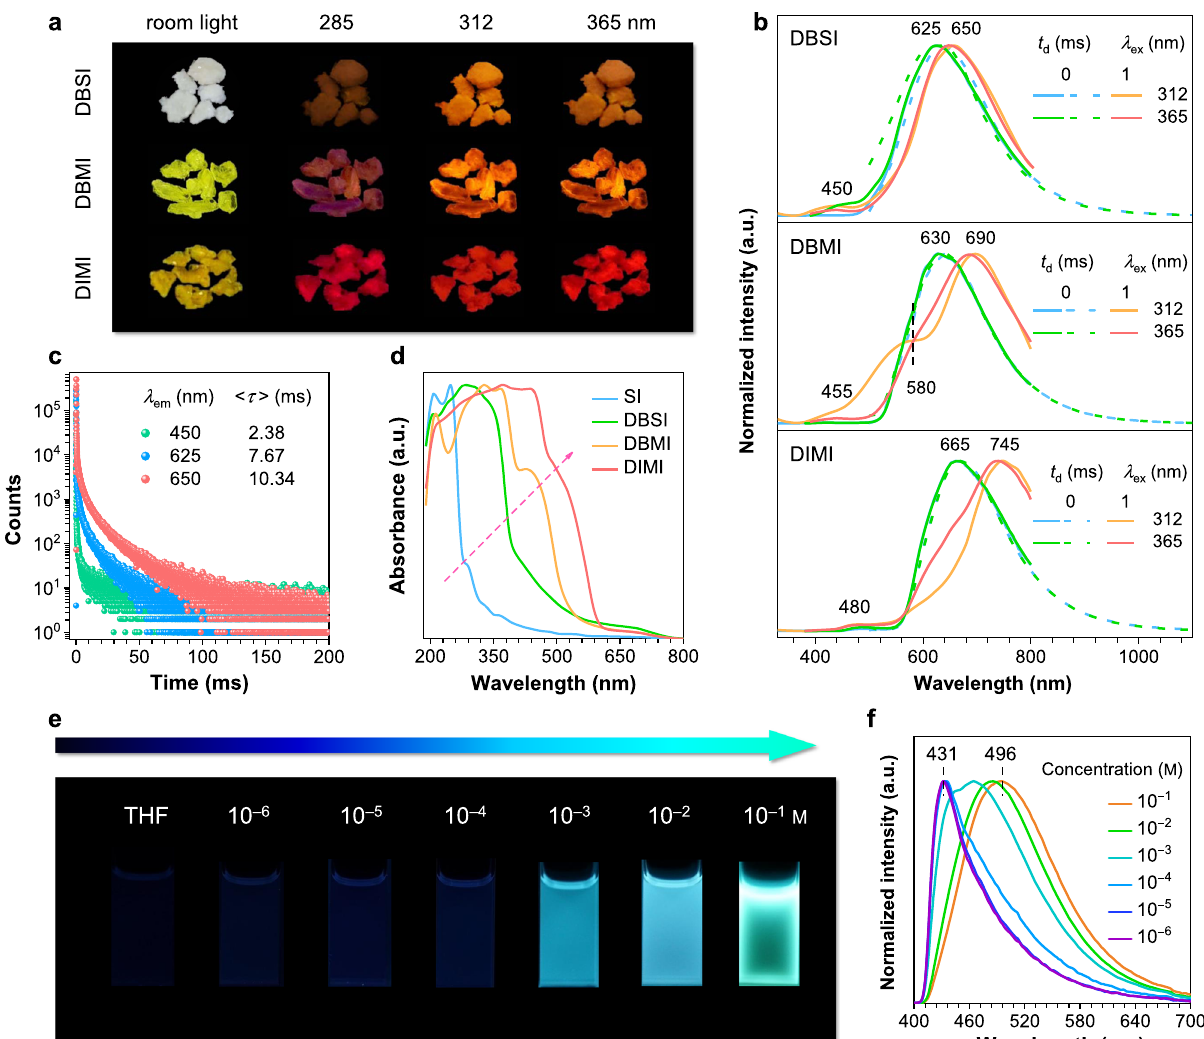
Fig. 2 Photophysical properties of DBSI, DBMI, and DIMI. a Photographs taken under room light or varying UV lights and b prompt ( t d = 0 ms) and delayed ( t d = 1 ms) emission spectra with varying λ ex s of DBSI, DBMI, and DIMI single crystals. c Lifetime pro fi les of DBSI single crystals monitored at different λ em s ( λ ex = 312 nm). d Absorption of different single crystals. e Photographs and f normalized emission spectra of varying DBSI/tetrahydrofuran (THF) solutions with 365 nm UV irradiation. Note : due to the detection limit of the standard PMT900 detector, the given prompt emission spectra are superposed by the data from a PMT900 detector (300 – 800 nm) and a NIRPMT detector (500 – 1200